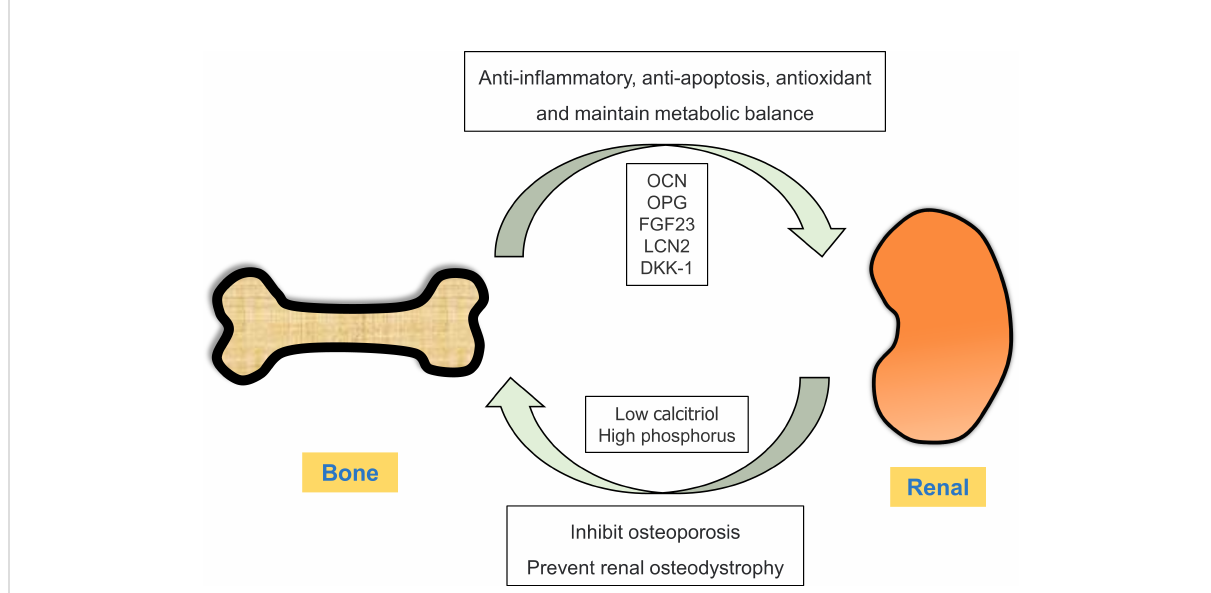
FIGURE 1 Crosstalk between the bone and kidney. Under physiological conditions, bones can secrete bone-derived peptides or proteins (OCN, OPG, FGF23 and LCN2) into the kidney through circulation. In ESRD, renal insuf fi ciency results in low calcitriol and high phosphorus levels, thereby disrupting the balance between bone synthesis and